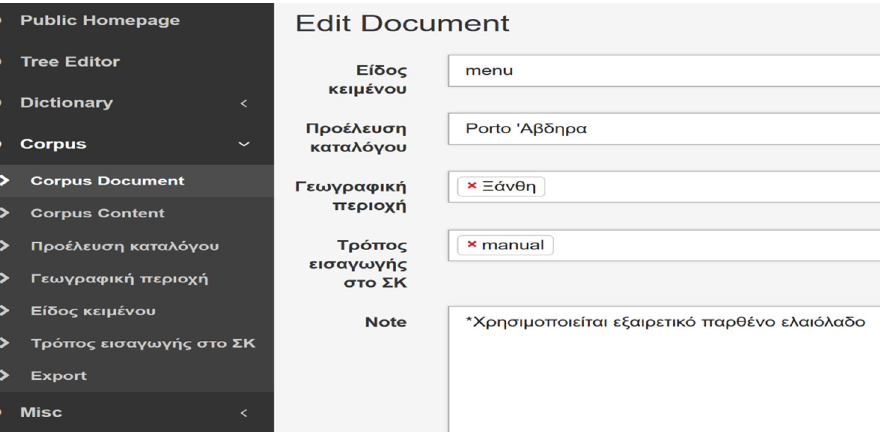
Figure 1: The administrator ’ s page and the interface for menu encoding in the web database application. Slots from top to bottom: type of text, the restaurant or tavern from which the menu was obtained, geographical area, and the way of encoding in the data base ( manual or harvesting the web )